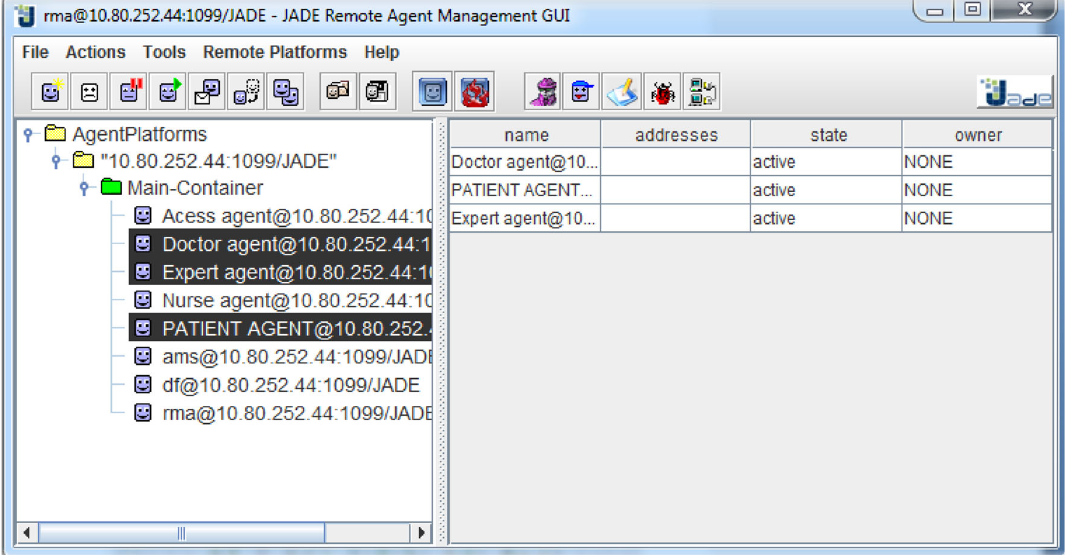
Fig. 3 Snapshot of the prototype in JADE